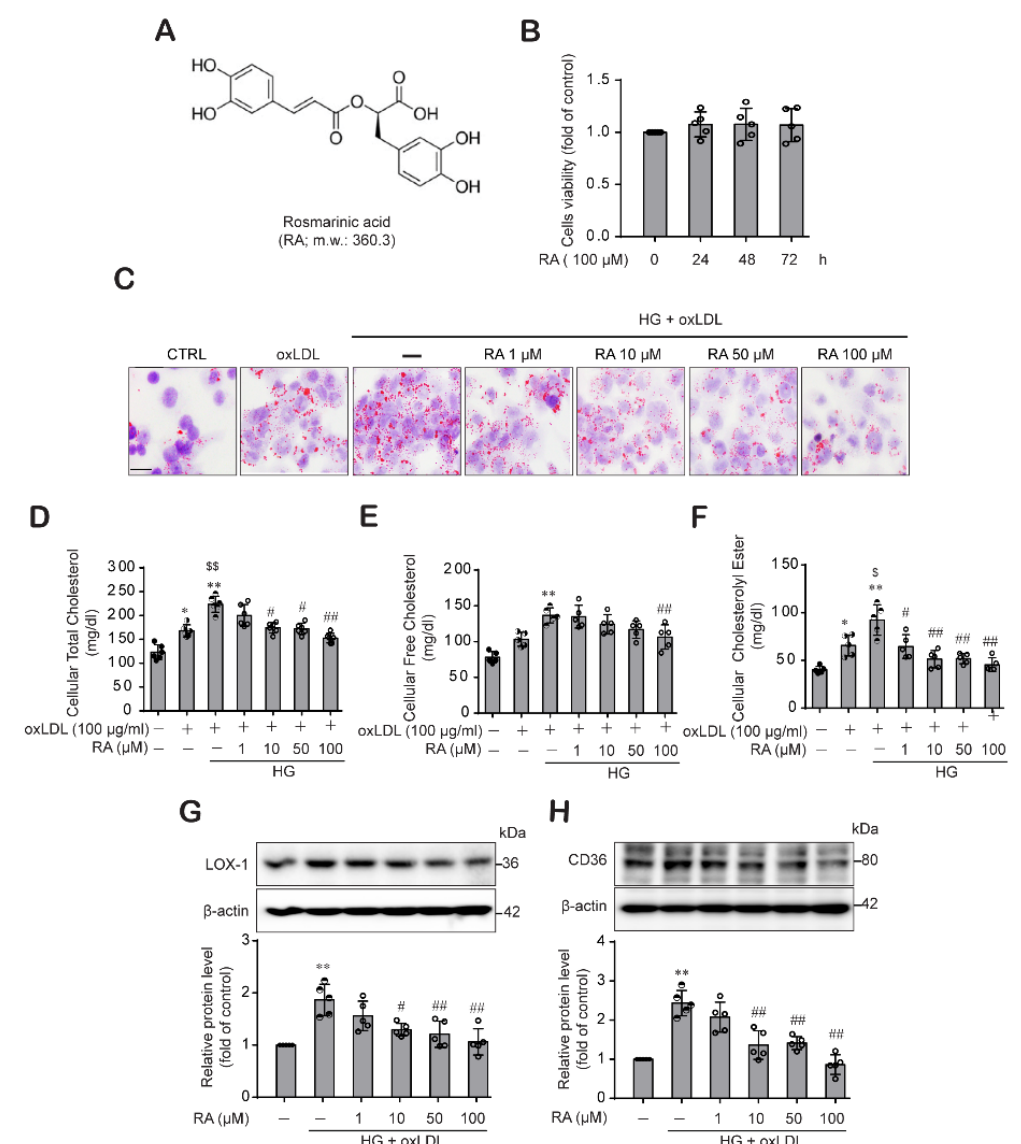
Figure 1. RA significantly reduced the oxLDL-induced lipid contents, cholesterol contents and levels of the SRs LOX-1 and CD36 in macrophage under HG conditions. ( A ) Chemical structure of RA. ( B ) Effect of RA on THP-1 macrophage viability. THP-1 macrophages were treated with RA (100 µ M) for 24, 48 and 72 h, and then cell viability was measured by the CCK-8 assay as described in the Methods section. Results are presented as the mean ± SD from five independent experiments. ( C ) THP-1 macrophages were treated with oxLDL (100 µ g/mL) under low glucose (5 mM) or HG (25 mM) conditions in the presence or absence of RA (1, 10, 50 and 100 µ M). After 24 h, intracellular lipids were stained with Oil Red O (ORO) and observed under light microscopy (400 × magnification) (scale bar: 50 µ m). Results were confirmed by repeated experiments. ( D – F ) Cells were treated as described above, and intracellular total cholesterol ( D ), free cholesterol ( E ) and cholesteryl ester ( F ) were measured with a cholesterol/cholesteryl ester quantitation kit according to the manufacturer’s instructions as described in the Methods section. LOX-1 ( G ) and CD36 ( H ) protein levels were analyzed from the cell lysates by western blot analysis. The data are presented as the mean ± SD of five independent experiments. * p < 0.05, ** p < 0.01 compared to the control; $ p < 0.05, $$ p < 0.01 compared to the oxLDL; # p < 0.05, ## p < 0.01 compared to the HG + oxLDL